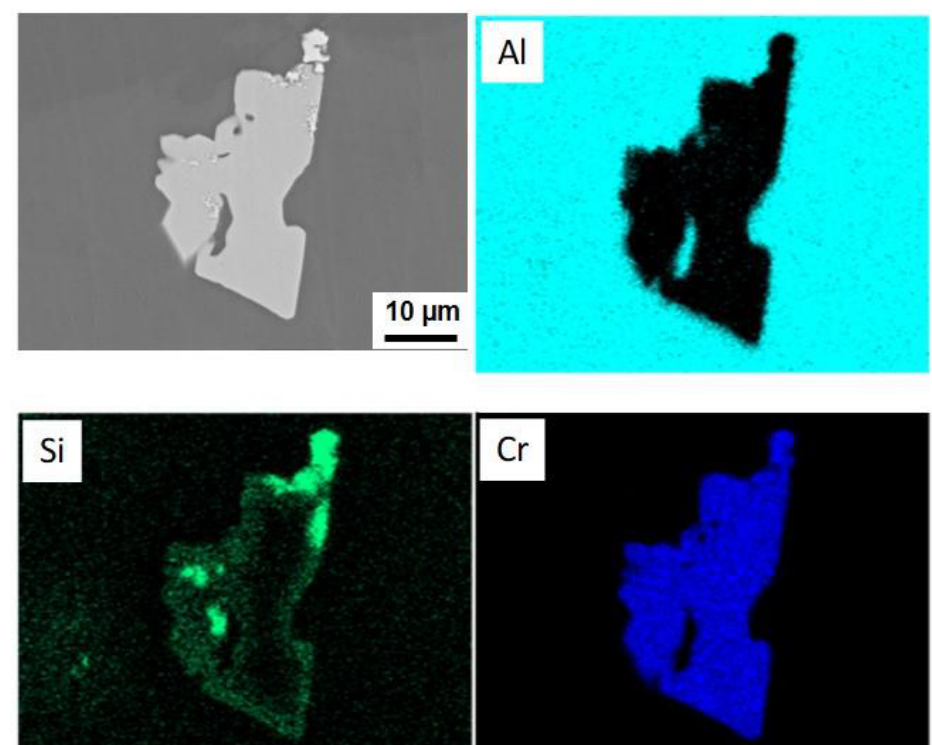
Figure 12. SEM images and element mapping of a particle of the second type.